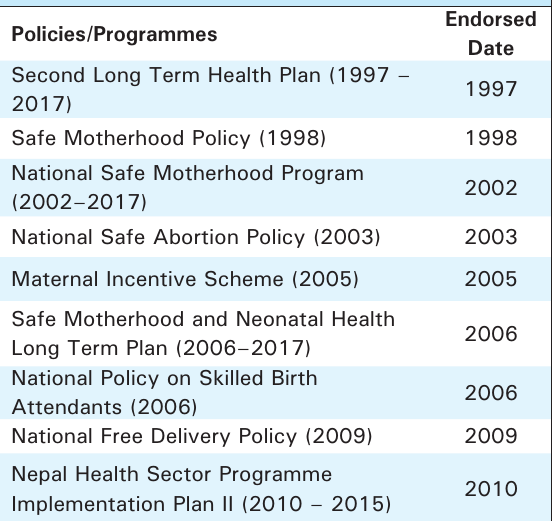
Table 1. Policies and programmes on maternal, neo- natal and child health in